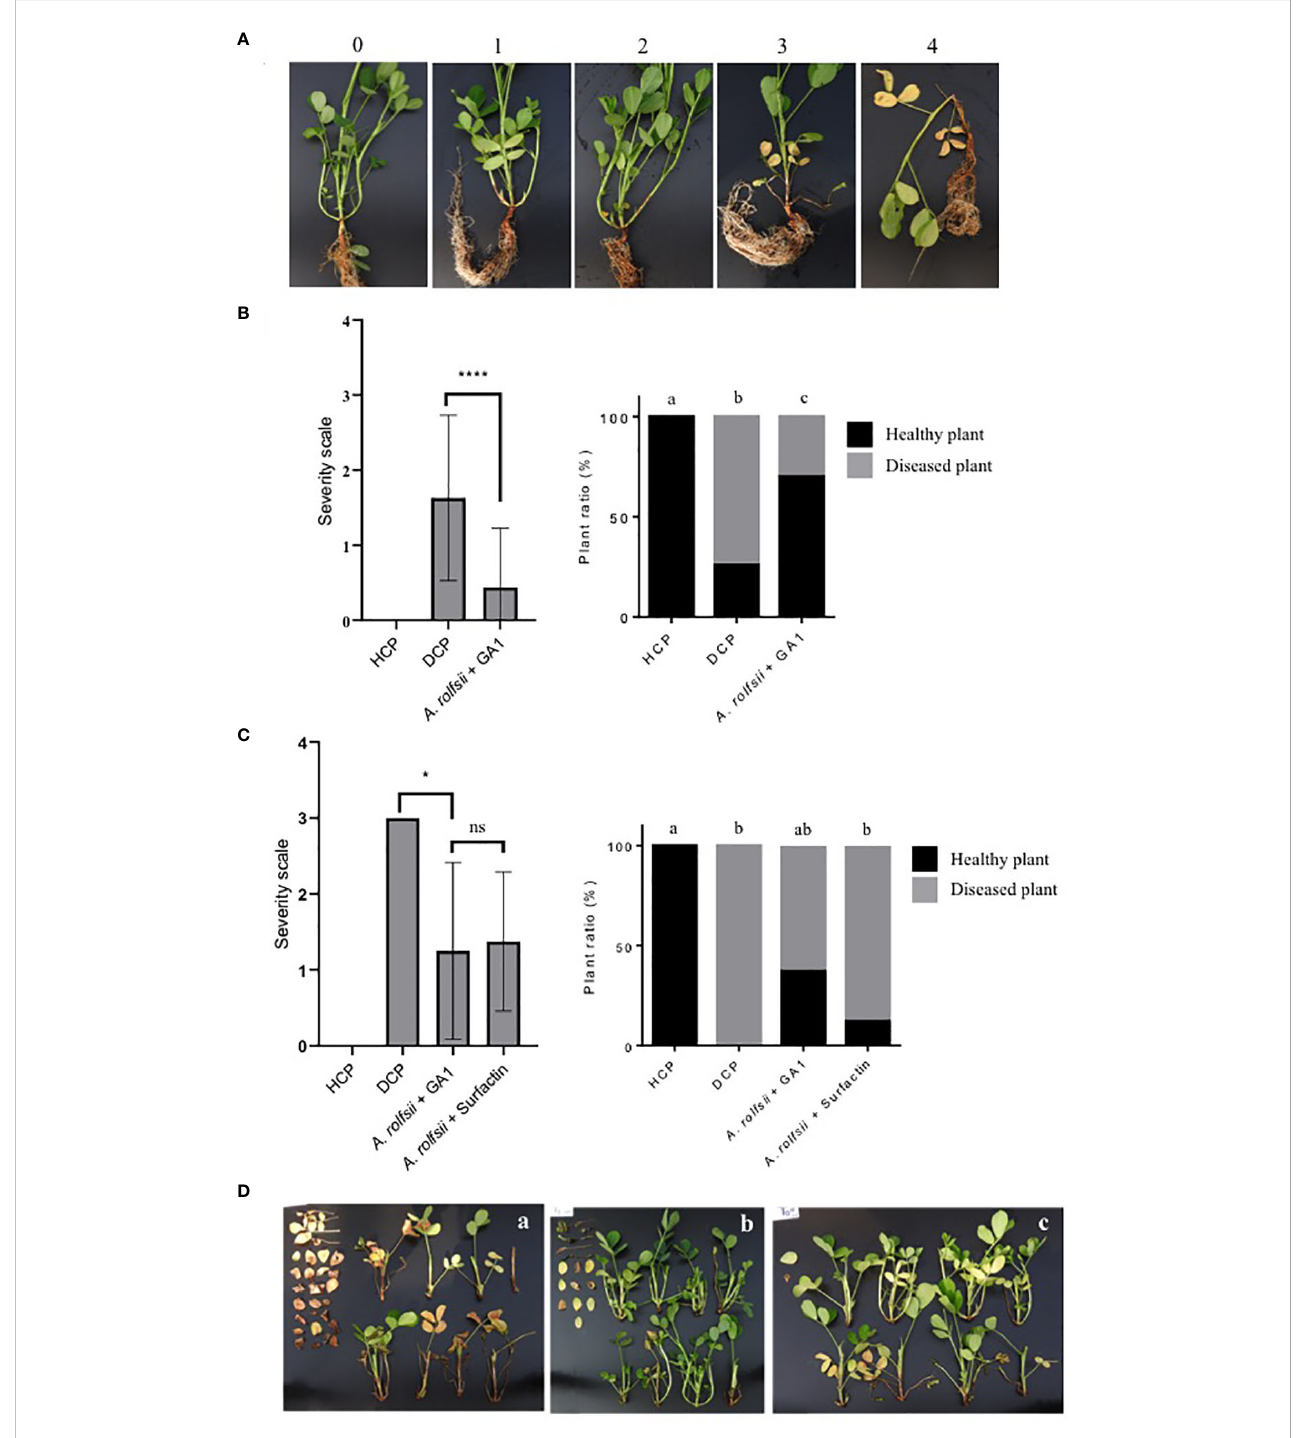
FIGURE 1 (A) Illustration of the severity scale used for disease rating. 0: no infection on the plant (Healthy plant); 1: mycelium present, and one branch infected; 2: mycelium present, and two branches infected; 3: mycelium present, three branches infected and beginning of leave ’ s yellowing; 4: three branches infected, wilting and at least 80% of leave ’ s yellowing. (B) Impact of B. velezensis GA1 direct antagonism against A. rolfsii on disease severity (left panel) and disease incidence (right graph), HCP = not infected plant, DCP = A. rolfsii infected plant; A. rolfsii + GA1 = Infected plants previously treated with B. velezensis GA1. Pearson ’ s chi-squared test followed by the pairwise tests of independence for nominal data were used to compare DI between modalities. Kruskal-Wallis ’ s test followed by Dunn ’ s multiple comparisons were used to compare DS between treatments. Means ± SD from fi fty replicates of two experiments are presented. ****, p < 0.0001. Treatments with different letters are signi fi cantly different (p < 0.05). (C) Impact of B. velezensis GA1 on the induced resistance of peanuts plants against A. rolfsii . Disease severity (left panel) and disease incidence (right graph) are depicted; A. rolfsii + surfactin = Infected plants previously treated with pure surfactin (10µM/per plant). Pearson ’ s chi-squared test followed by the pairwise tests of independence for nominal data were used to compare DI between modalities. Kruskal-Wallis ’ s test followed by Dunn ’ s multiple comparisons were used to compare DS between treatments. Means ± SD from eight replicates of one experiment are presented. *, p<0.05 and ns (no signi fi cant difference), p > 0.05. Treatments with different letters are signi fi cantly different (p < 0.05). (D) Pictures showing the extent of disease symptoms as observed on several randomly collected plants for DCP (A) , A. rolfsii infected plants treated with GA1 (B) or infected plants treated with surfactin (C) . The detached leaves on the left of each image are from branches located near the collar and damaged by A. rolfsii